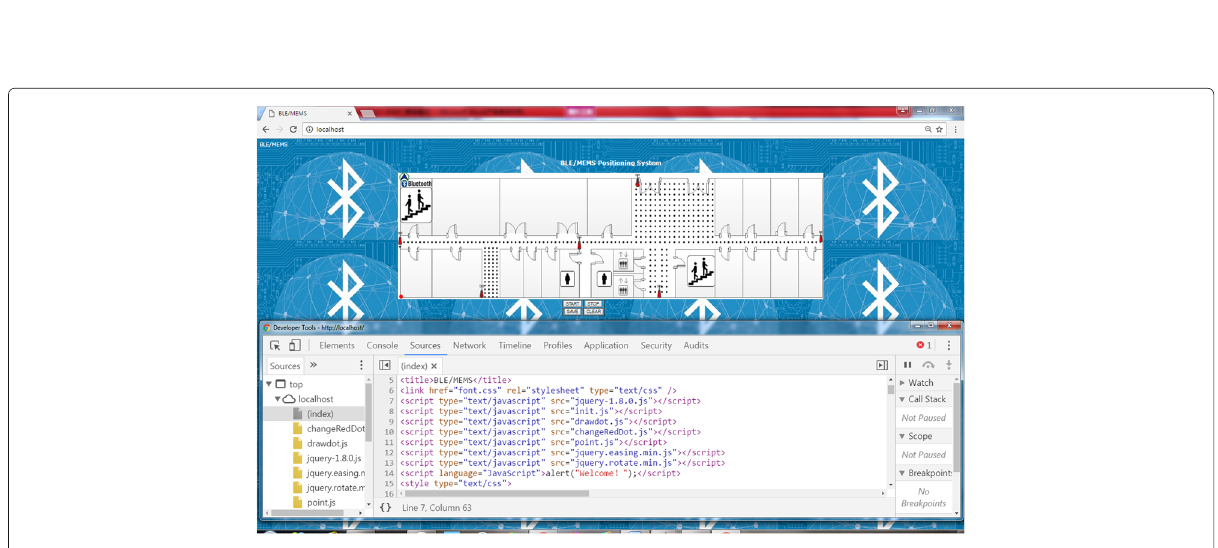
Fig. 11 Interface of positioning server